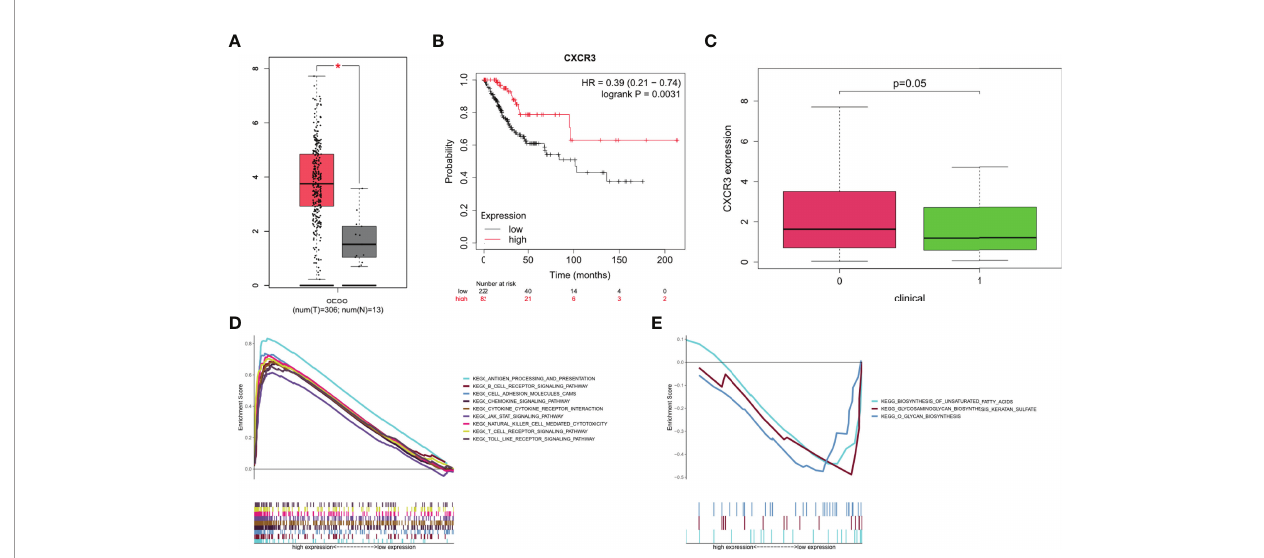
FIGURE 6 | Survival analysis, clinical characteristics and GSEA for samples with high CXCR3 expression and low expression of CESC patients. (A) Differentiated expression of CXCR3 in the normal and tumor sample. (B) Survival analysis for CESC patients with different CXCR3 expression. Patients were labeled with high expression or low expression. (C) The correlation of CXCR3 expression with survival stage(fustat: 0 = survival, 1 = death). (D) Enriched gene sets in KEGG of high CXCR3 expression. Only several leading gene sets are shown in plot. (E) Enriched gene sets in KEGG by the low CXCR3